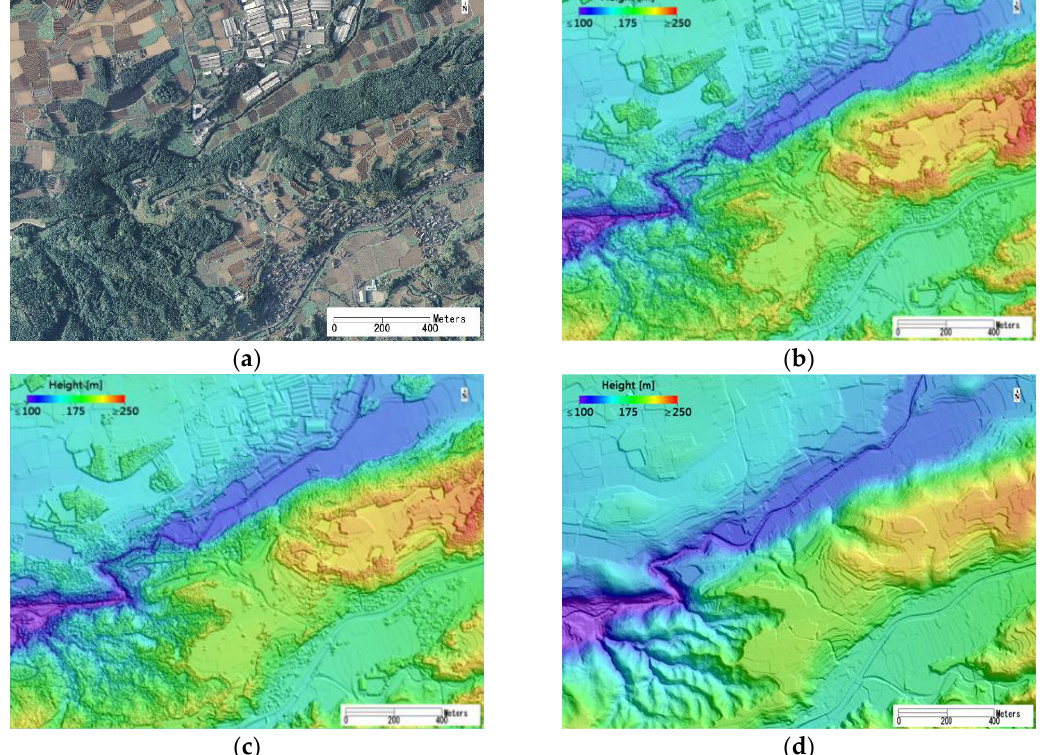
Figure 4. The aerial photo and the transformed raster images of Lidar data in grid 2KD673: ( a ) The ortho-image on 15 April 2016, with 16-cm spacing; ( b ) the DSM image with 1-m spacing acquired on 15 April 2016; ( c , d ) the DSM and processed DTM images with 2-m spacing acquired on 15 May 2006.